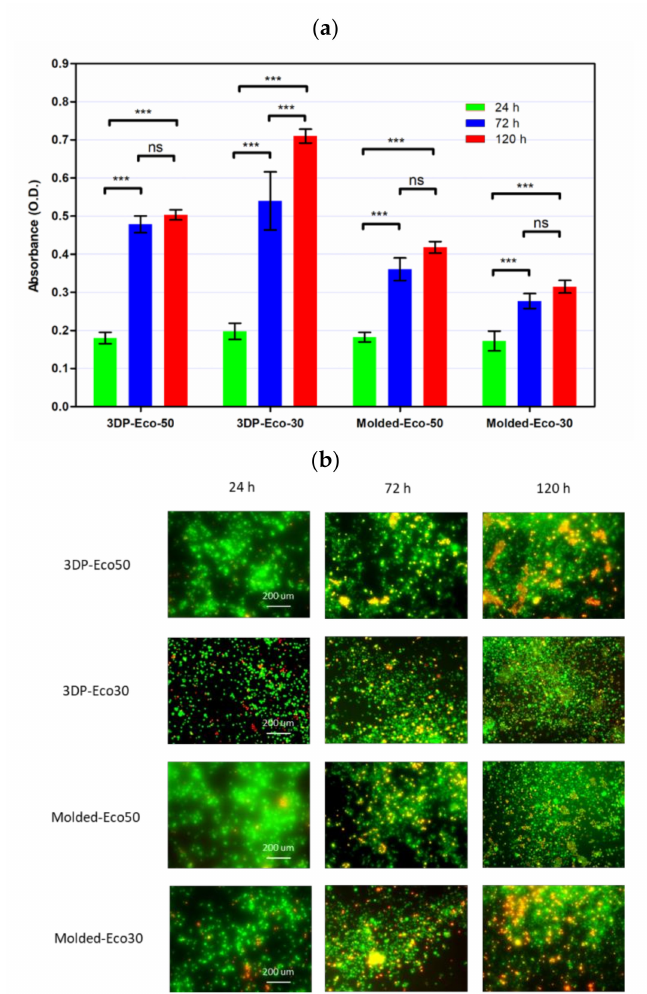
Figure 11. ( a ) Cell proliferation of re-seeded L929 cells on printed / casted Eco50 / Eco30 substrates after 24, 72, and 120 h culture was quantified based on the WST-8 cell proliferation assay. ( b ) Fluorescent images of re-seeded L929 cells on printed / casted Eco50 / Eco30 substrates after 24, 72, and 120 h culture. Cells were stained with the Live / Dead ® cell viability assay. Statistical significance between groups was assessed using two-way analysis of variance (ANOVA) followed by Bonferroni post-tests. ns = p > 0.05 and *** = p <